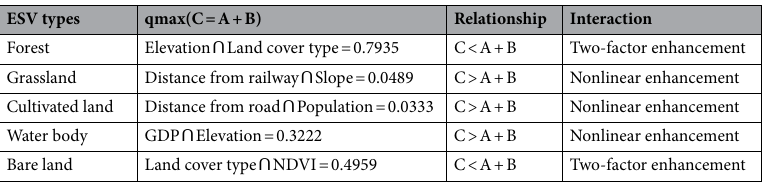
Table 8. Influence of interaction of spatial driving forces on ESV for each land use type.